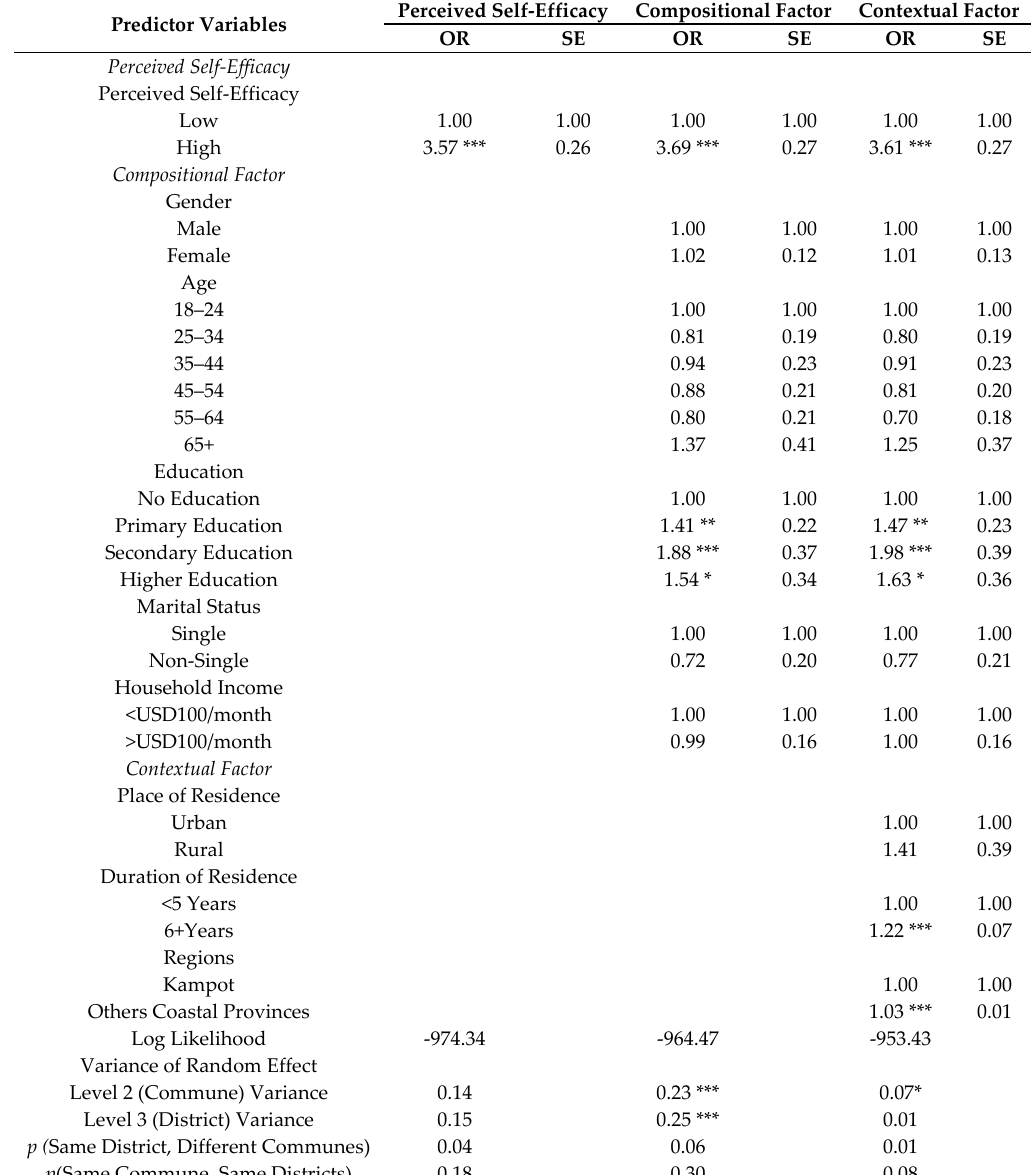
Table 5. Multivariate Logistic Regression Analysis on Reactive Adaptation to Climate Change in Coastal Cambodia ( n =